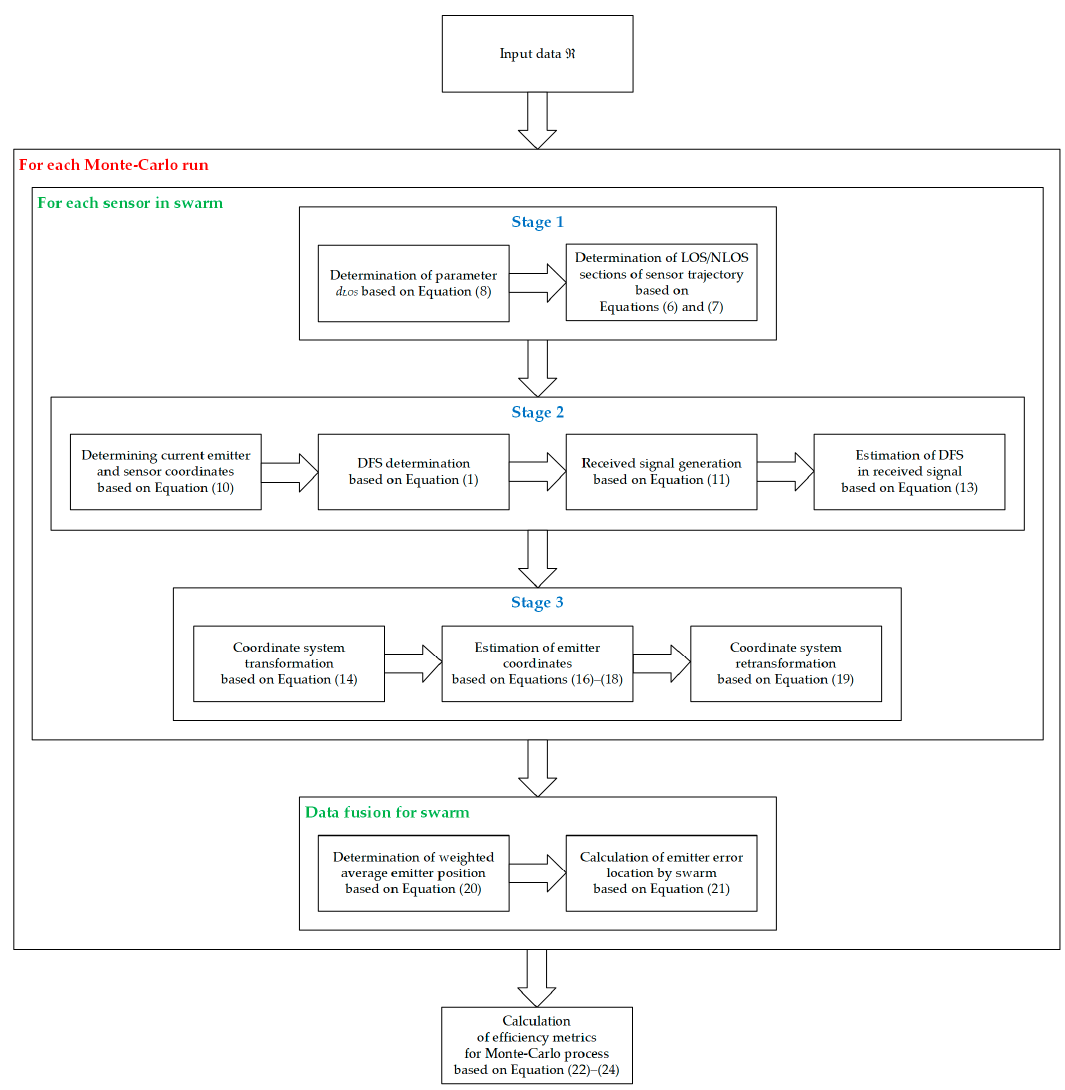
Figure 2. Generalized diagram of the simulation procedure.